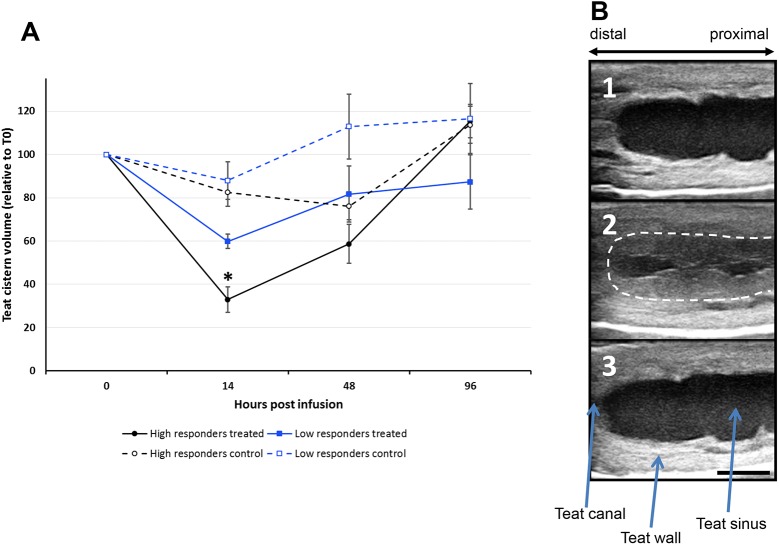
Ultrasonographic assessment of the teat cistern volume following ovalbumin infusion.
(A) Graph representing the evolution of the teat cistern volume (mean values from 10 responders and 4 low responders, ± standard deviations) relative to T0 (before ovalbumin infusion) showing a significant reduction of the teat cistern volume 14 hours after ovallbumin infusion into teat cisterns of high-responder cows (*p<0.05); (B) Ultrasounds photographs representing an ovalbumin-infused teat before infusion; (1): the cistern is filled with liquid (milk) therefore weakly echogenic; (2) 14 hpi, there was a thickening and permeabilization of the wall of the teat (inflammation) reducing the cistern volume. The white dashed line represents the initial position of the cistern wall; (3) 96 hpi, the teat has regained its original appearance. The bar represents 1 cm.